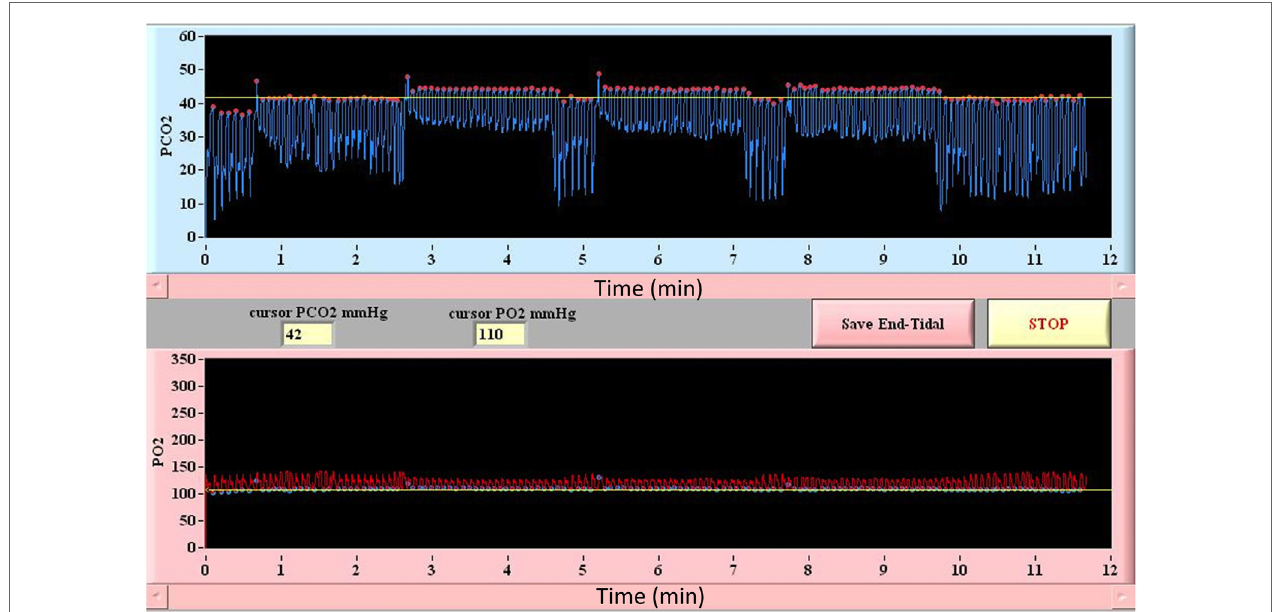
FiGUre 3 | Block design breathing protocol using model-based prospective end-tidal etCo 2 and eto 2 targeting . Triple hypercapnic stimulus during controlled iso-oxic conditions is illustrated. Breath-by-breath confirmation of ETCO 2 and ETO 2 allows for accurate measurement and interpretation of CVR